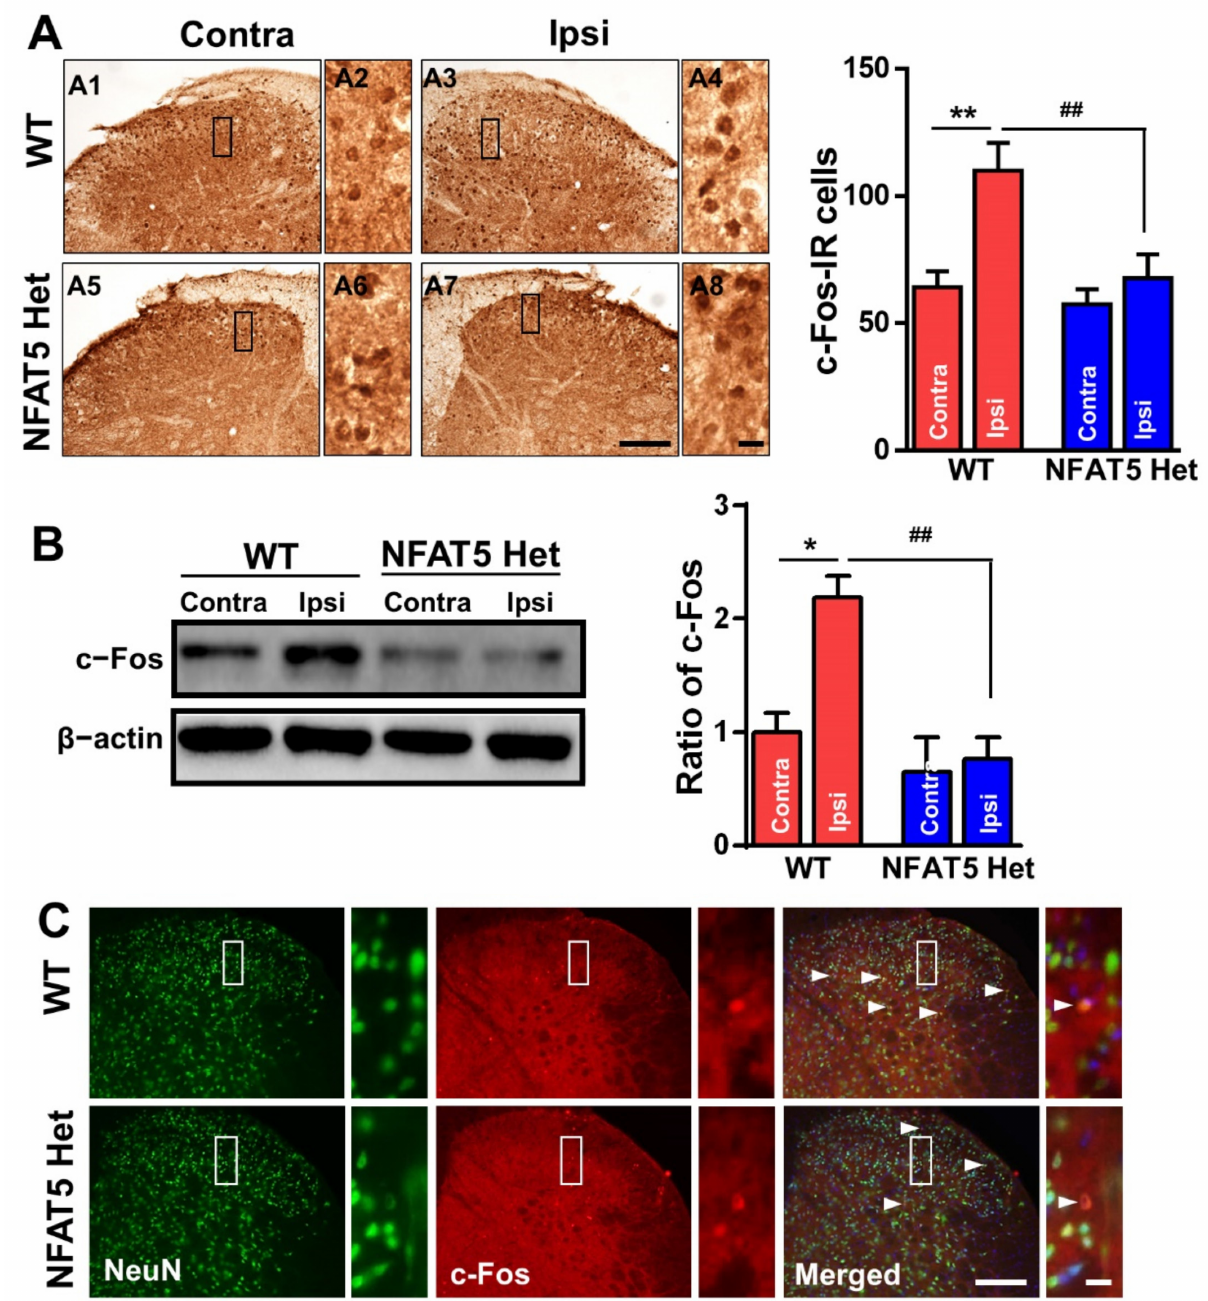
Figure 3. Formalin-induced c-Fos expression in the spinal dorsal horns of wild-type (WT) and NFAT5-Het mice. ( A ) At 1 h following formalin injection, lumbar (L) 4–6 fragments of the spinal cord from WT and NFAT5-Het mice were processed and immunostained with anti-c-Fos antibody. Scale bar: 50 µ m (left), 20 µ m (right). The numbers of c-Fos-immunoreactive (IR) cells were quantified in contralateral (contra) and ipsilateral (ipsi) sides of the spinal dorsal horn in WT and NFAT5-Het mice. Data are expressed as the means ± SEMs (one-way ANOVA with Tukey’s post, * p < 0.05 vs. WT contra, ** p < 0.01 vs. WT contra, ## p < 0.01 vs. WT ipsi, n = 5). ( B ) The protein levels of c-Fos were assessed in contralateral and ipsilateral sides of the spinal dorsal horn 1 h after formalin injection by Western blot. Band intensities expressed as the ratio of c-Fos normalized to β -actin, which was used as a loading control. Data are expressed as the means ± SEMs (one-way ANOVA with Tukey’s post-hoc test, * p < 0.05 vs. WT contra, ## p < 0.01 vs. WT ipsi, n = 5). ( C ) The same sections from (A) above were also co-stained with anti-c-Fos and anti-NeuN antibodies. Arrow heads indicate c-Fos/NeuN-positive cells. Scale bar: 50 µ m (left), 20 µ m